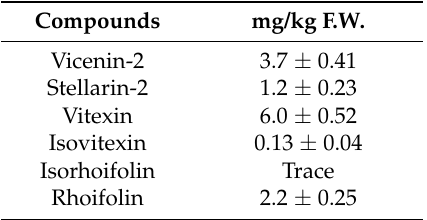
Table 3. Flavonoids content in methanol extract of Jatropha curcas L.